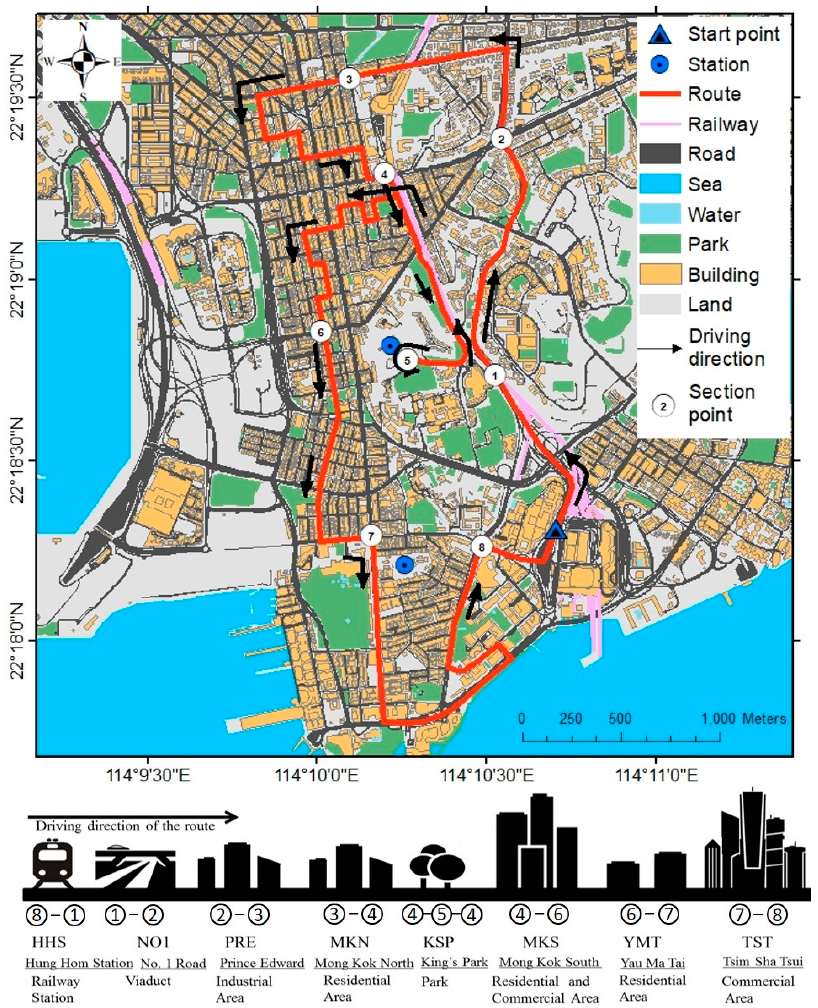
Figure 2. ( Top ) The designed traverse route in the Kowloon Peninsula. ( Bottom ) Sketch of the features along the two designed routes.